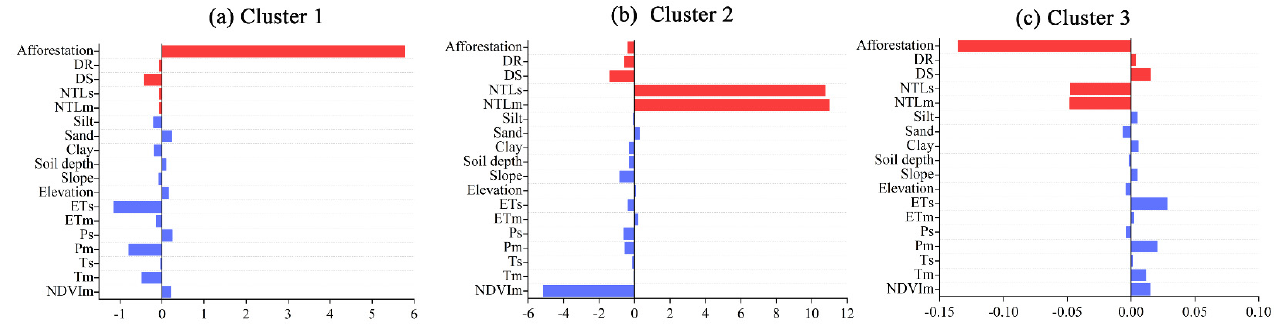
Figure 5. Z–score normalized values of drivers characterizing the three archetypes of socio-environmental factors: zero represents the mean of the factors; the natural drivers are presented in blue and the human drivers shown in red.